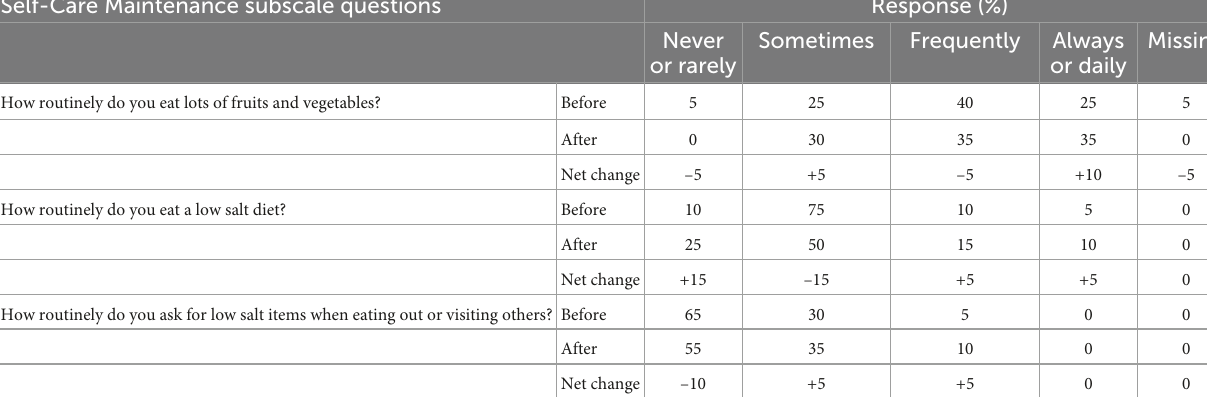
TABLE 2 Categorical sum of participant responses to selected Self-Care Maintenance subscale questions, before and after receiving intervention. Self-Care Maintenance subscale